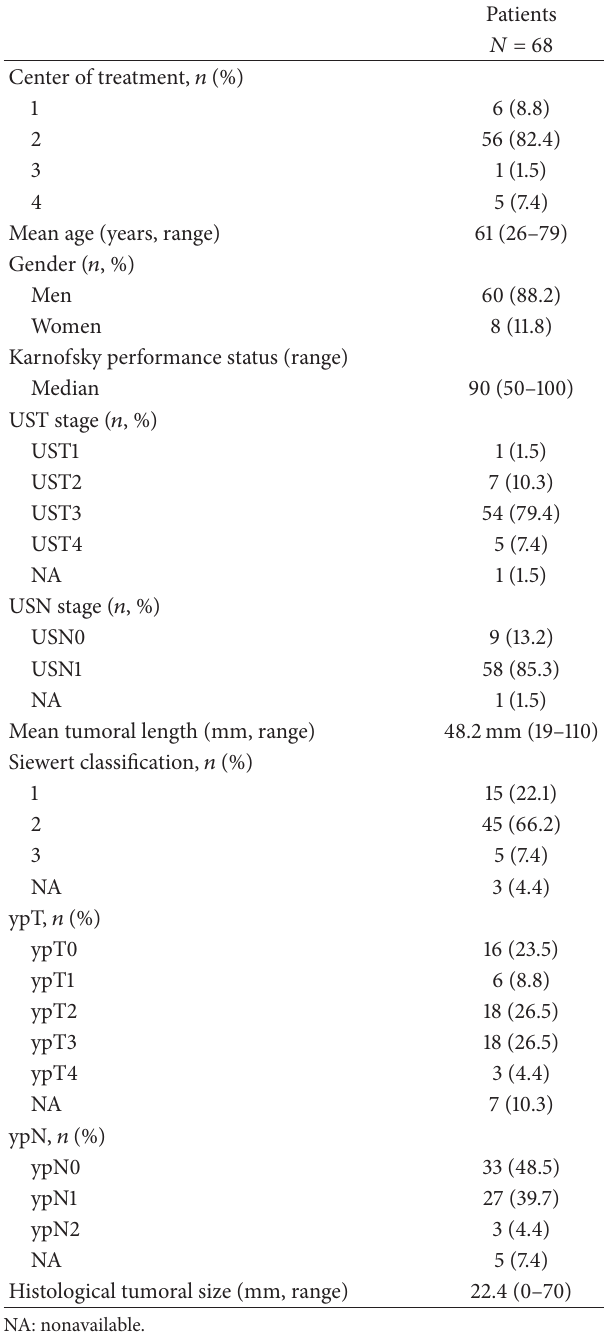
Table 1: Patient, tumor, and characteristics.